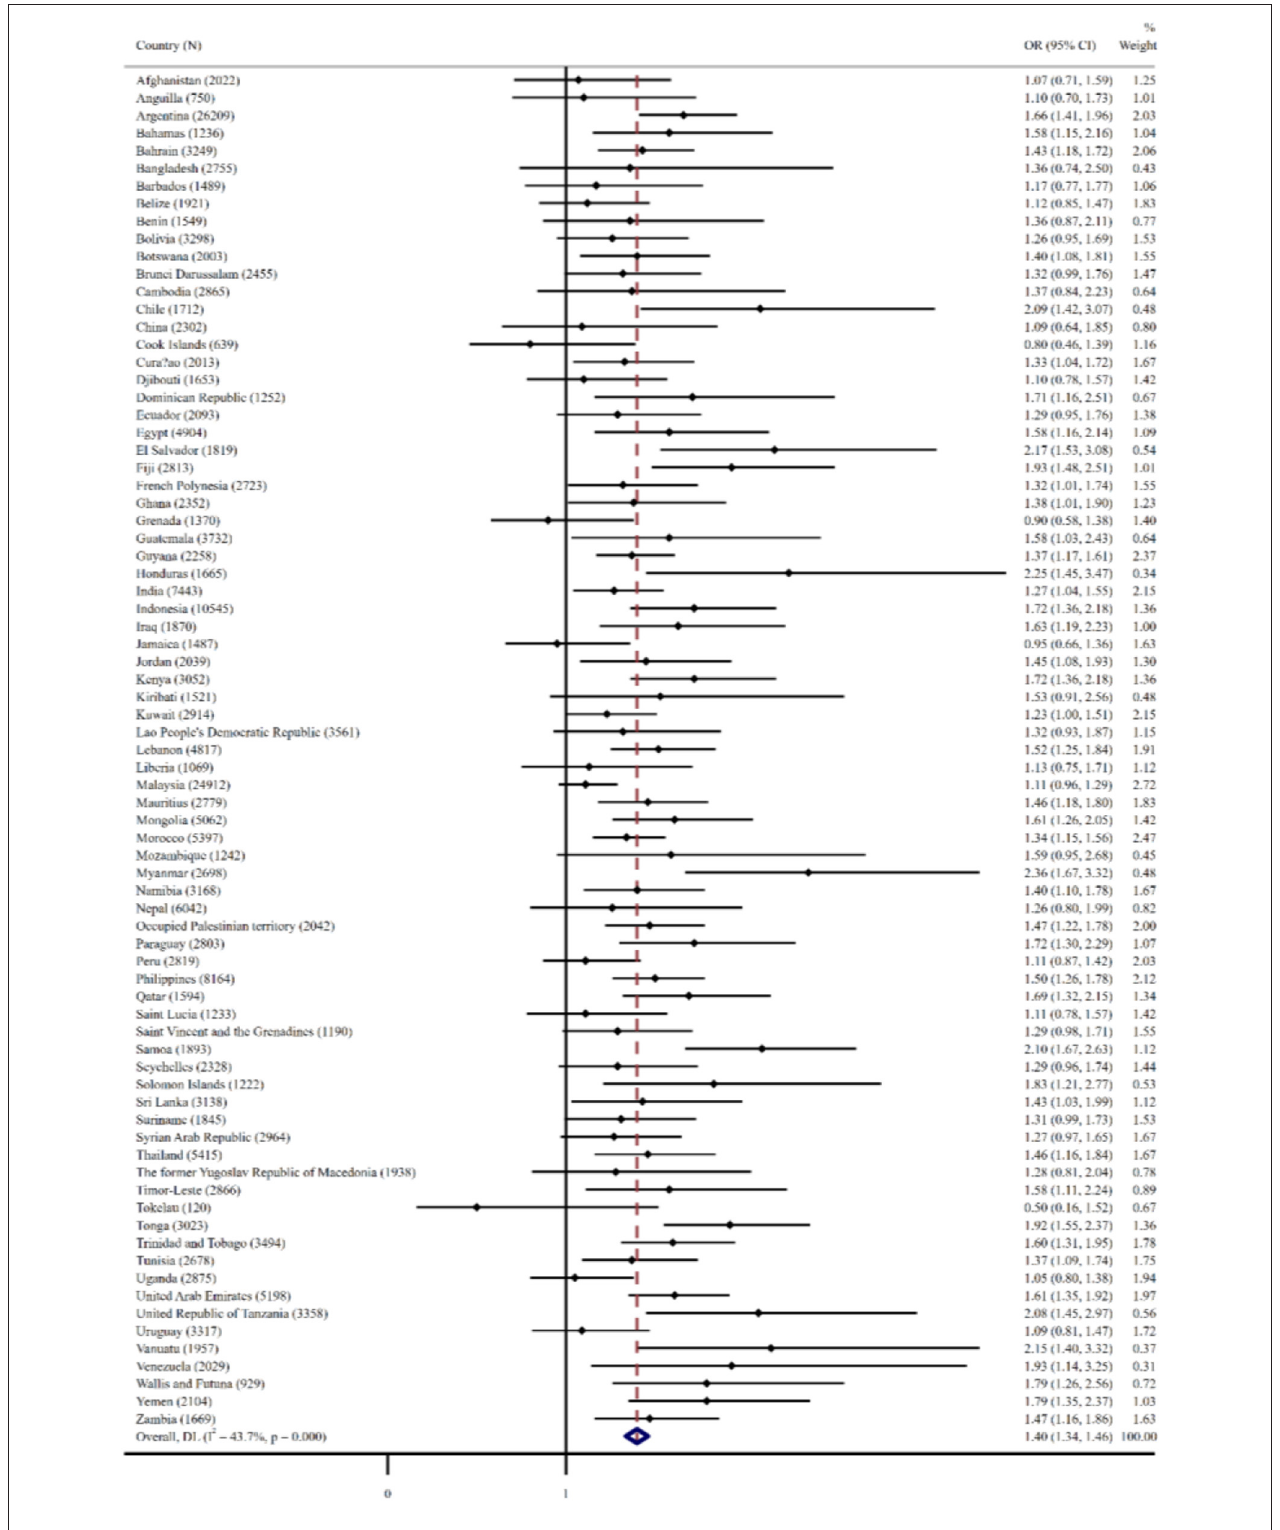
FIGURE 2 | The relationship between anxiety-induced sleep disturbance and more than 3h of the time spent sedentary behavior in different countries by multivariable logistic regression. Anxiety-induced sleep disturbance was defined as answering “most of the time” or “always” to the question “During the past 12 months, how often have you been so worried about something that you could not sleep at night?” The regression models are adjusted age, gender, went hungry past 30 days, and physical activity. The overall result was estimated by fixed effect model. OR, odds ratio; CI, confidence interval; N, sample size.